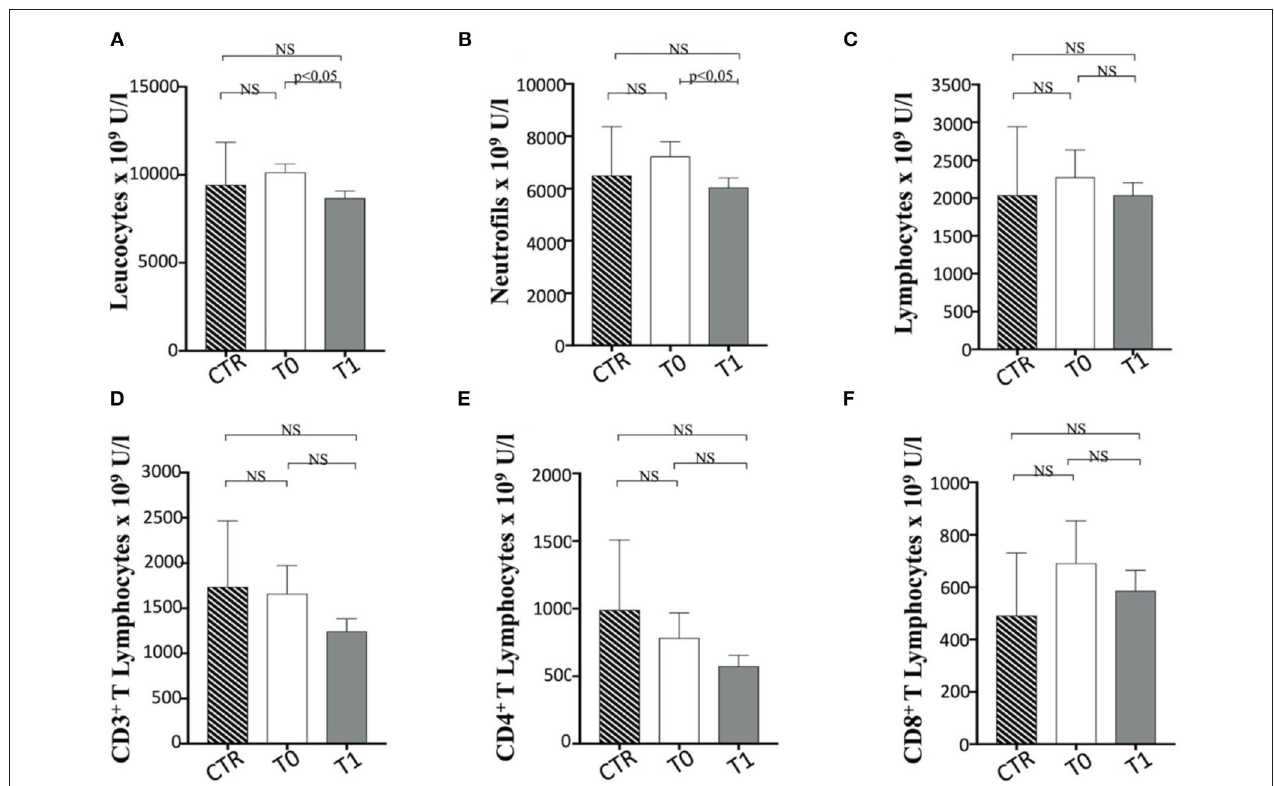
FIGURE 7 | The number of Leucocytes, neutrophils and T cell subsets in enrolled dogs. The figure reports the evaluation on the number of (A) leukocytes, (B) neutrophils, (C) total lymphocytes, (D) CD3 + , (E) CD4 + , and (F) CD8 + T cell subsets in obese dogs, at T0 and T1, and control (CTR) subjects. Referred values in “ n × 10 9 U/L” indicate results obtained in CTR group (dashed column), in obese dogs at T0 (white column) and T1 (gray column), as indicated. Statistics: Wilcoxon matched pairs signed-rank test was used for T0 and T1 comparation in obese dogs, while Mann-Whitney test was performed for the comparation between T0 obese dogs and CTR subjects. NS means not significant